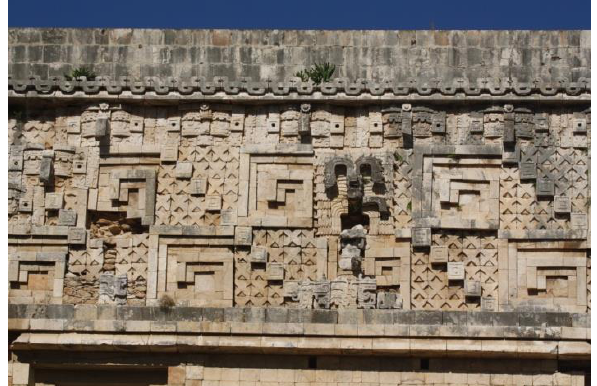
Figure 10. Detail of the Palace of the Governor’s upper frieze. (Photo G. Muñoz 2016).